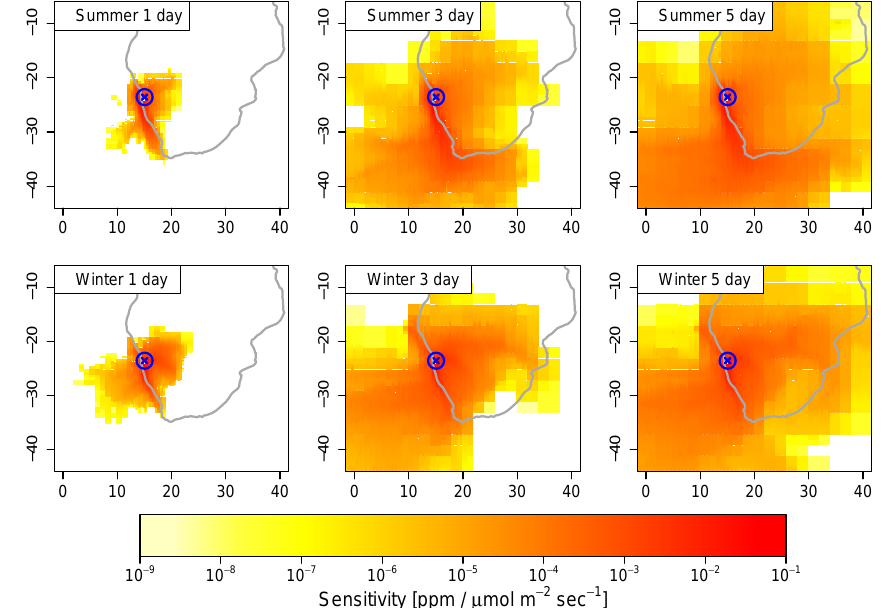
Figure 1. Average integrated footprints for NDAO during 2012–2013, using the Stochastic Time-Inverted Lagrangian Transport (STILT) model (Lin et al., 2003), driven by European Centre for Medium-Range Numerical Weather Prediction (ECMWF) meteorological fields on a 0.25 ◦ × 0.25 ◦ grid. The domain chosen to run the model was 5 ◦ N to − 45 ◦ S, − 30 ◦ W to 40 ◦ E. Average austral summer (November– February) footprints are shown in the top row and average austral winter (June–September) footprints are shown in the bottom row, integrated over 1, 3, and 5 days. The pixel size increases in distance from NDAO due to the dynamic grid resolution of the